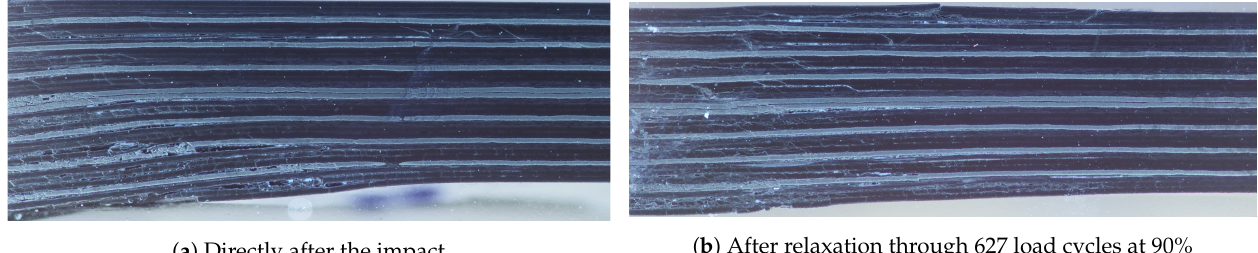
Figure 11. Polished cross sections of 35J impact damage of one specimen cut after the impact ( a ) and a second specimen cut after relaxation due to fatigue loading ( b